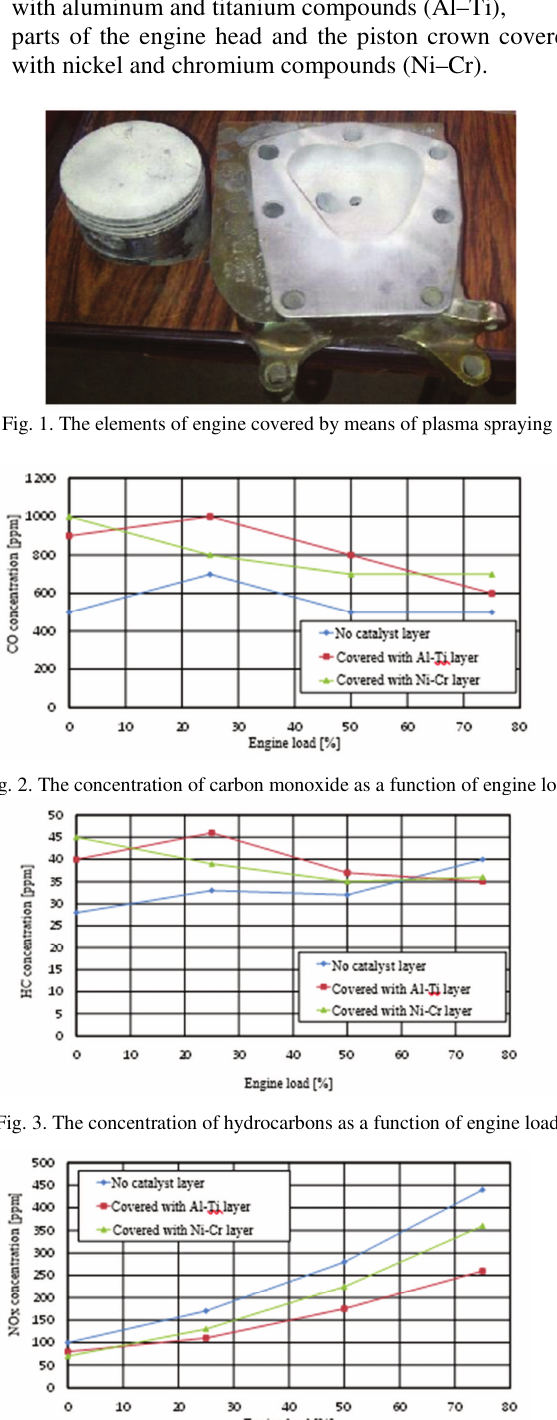
Fig. 4. The concentration of nitrogen oxides as a function of engine